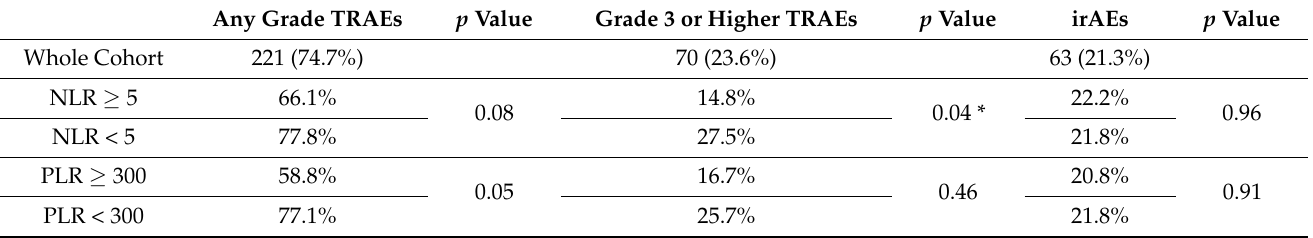
Table 4. Incidence of Treatment-Related Adverse Events According to NLR and PLR